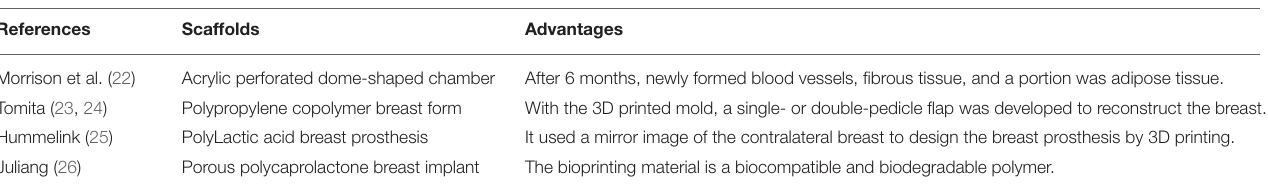
TABLE 2 | Summary of 3D printing scaffold in breast